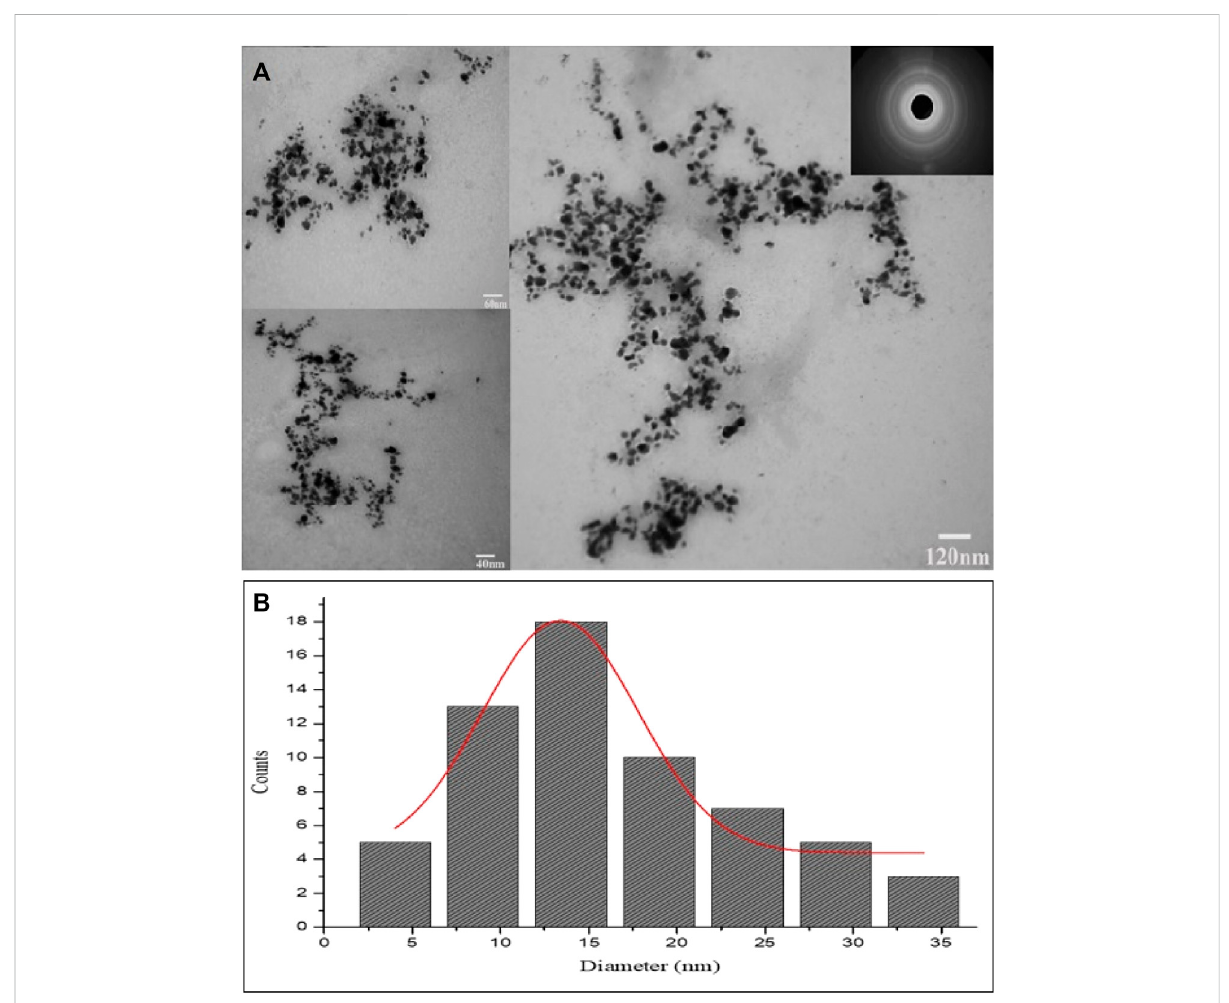
FIGURE 5 (A) TEM images and SAED pattern of the green synthesized AgNPs. (B) Histogram showing size distribution of the synthesized